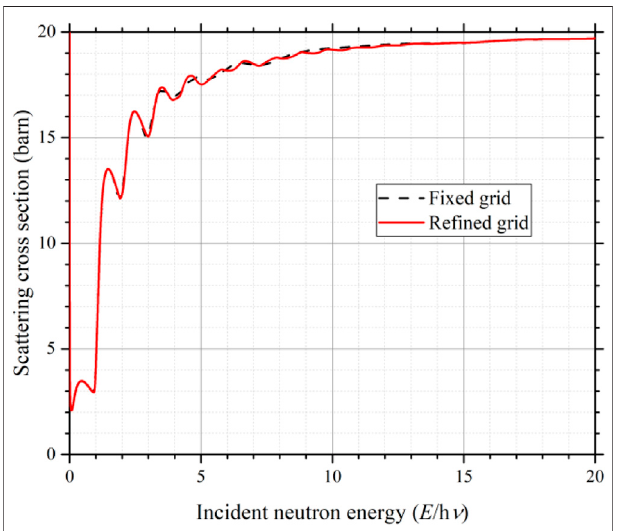
FIGURE 8 | Inelastic scattering cross section of YH2 as a function of numbers of hv .